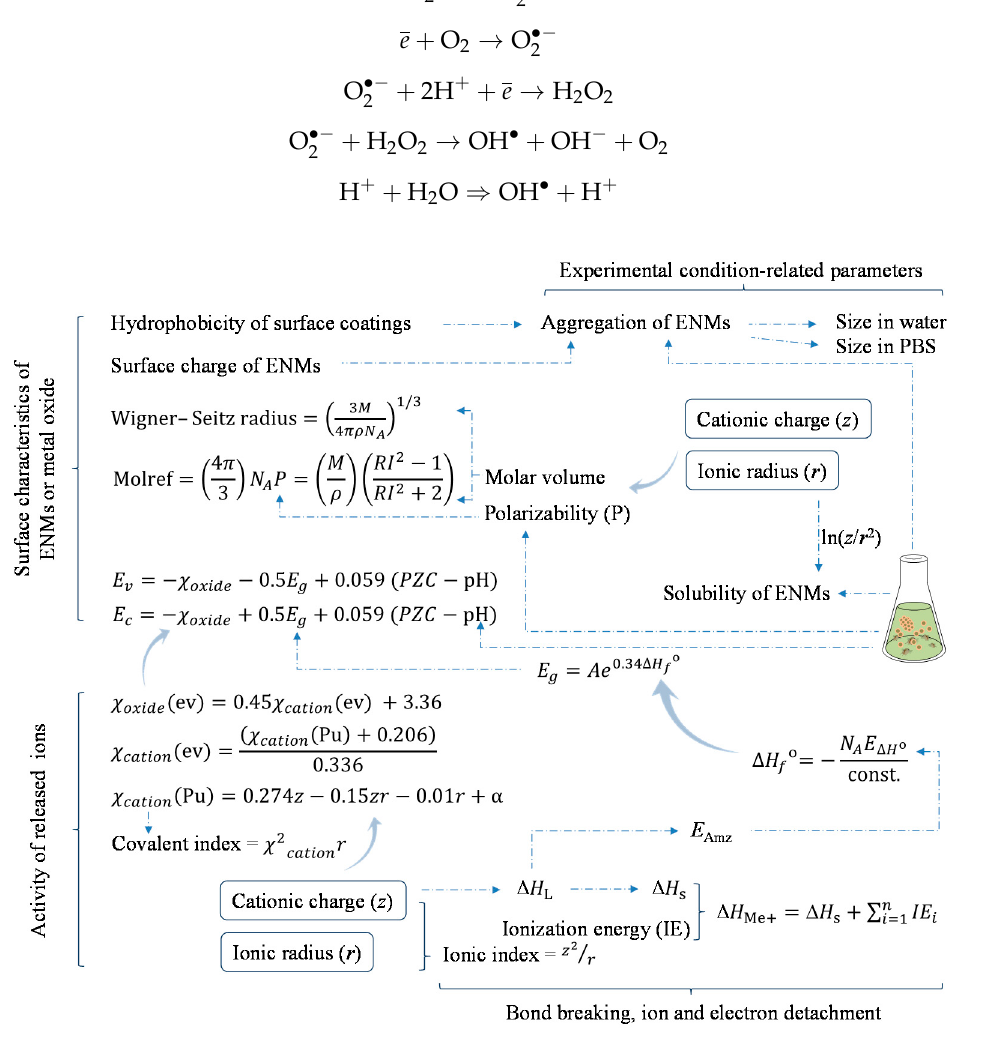
Figure 3. Profiling the toxicity of metal-based ENMs based on identified descriptors. Dashed line indicates the simplified (mutual) correlation between the descriptors. The descriptors are grouped as relating to the surface characteristics of ENMs or metal oxide, the activity of released ions, the bond breaking, ion and electron detachment, and the medium-related parameters. Molref, molar refractivity; M , molecular weight; ρ , density; N A , Avogadro’s number; RI, refractive index; PZC, point of zero charge; E v , valence band energy; E c , conduction band energy; E g , band gap; χ oxide , electronegativity of metal oxide; χ cation , electronegativity of cation; E Amz , atomization energy; ∆ H L , lattice energy; ∆ H s , enthalpy of sublimation; ∆ H Me+ , enthalpy of formation of a gaseous cation having the same oxidation state as that in the metal oxide structure; ∆ H f 0 , enthalpy of formation of metal oxide nanocluster representing a fragment of the surface; E ∆ H 0 , energy associated with a single metal-oxygen bond in the metal oxide; PBS, phosphate buffered saline.